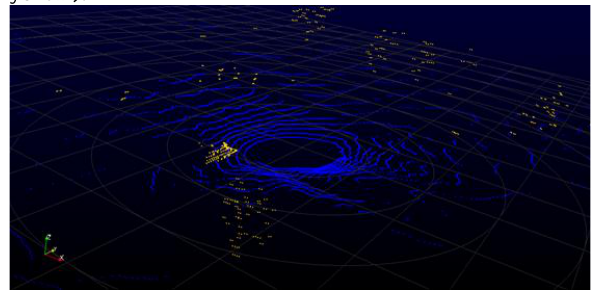
Figure 4. Modelled LiDAR data